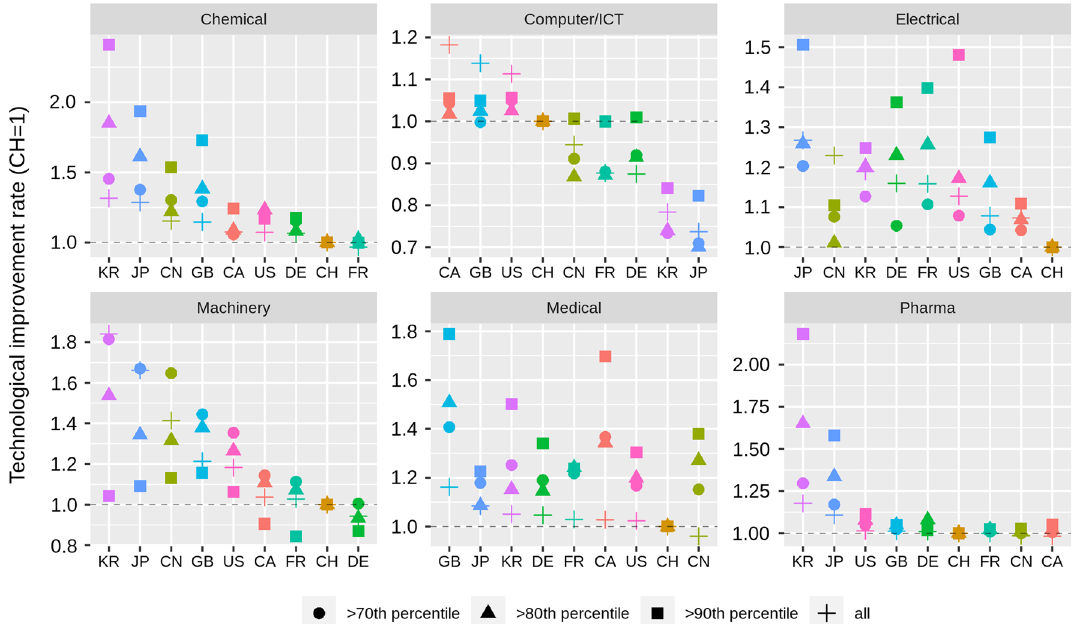
Fig. 11 Average technological improvement rates of all patents of different industries for different percentile subsets. Notes : Calculations based on improvement rates of 1757 technologies taken from Singh et al. (2021) that were matched to USPTO patents between 2010 and 2015. The average technological improvement rate is normalized according to the value of Switzerland. The plot shows average improvement rates for patents whose improvement rate is above the xth percentile of a given country. For comparison, the dots labeled as all show the averages across all patents as used in the main